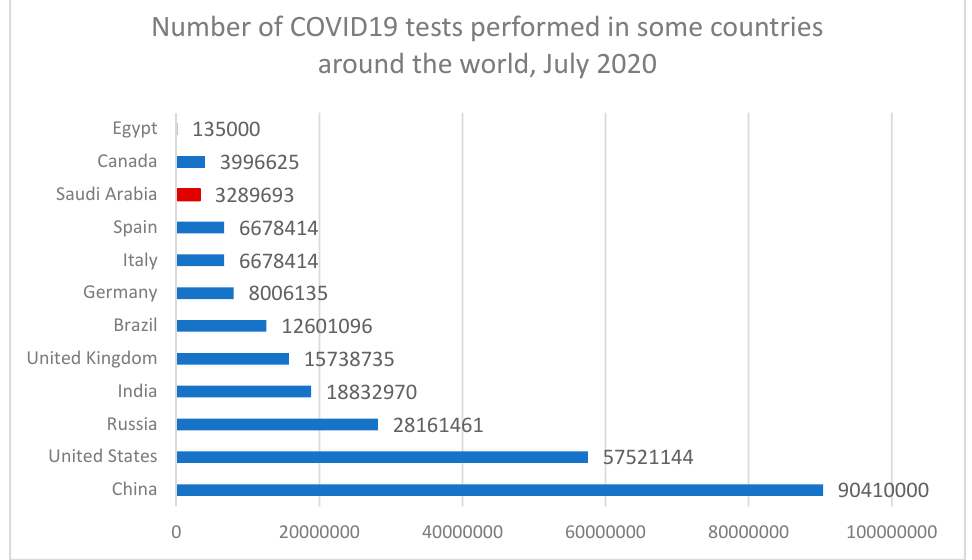
Figure 6. Number of COVID-19 tests performed in some countries around the world in July 2020.